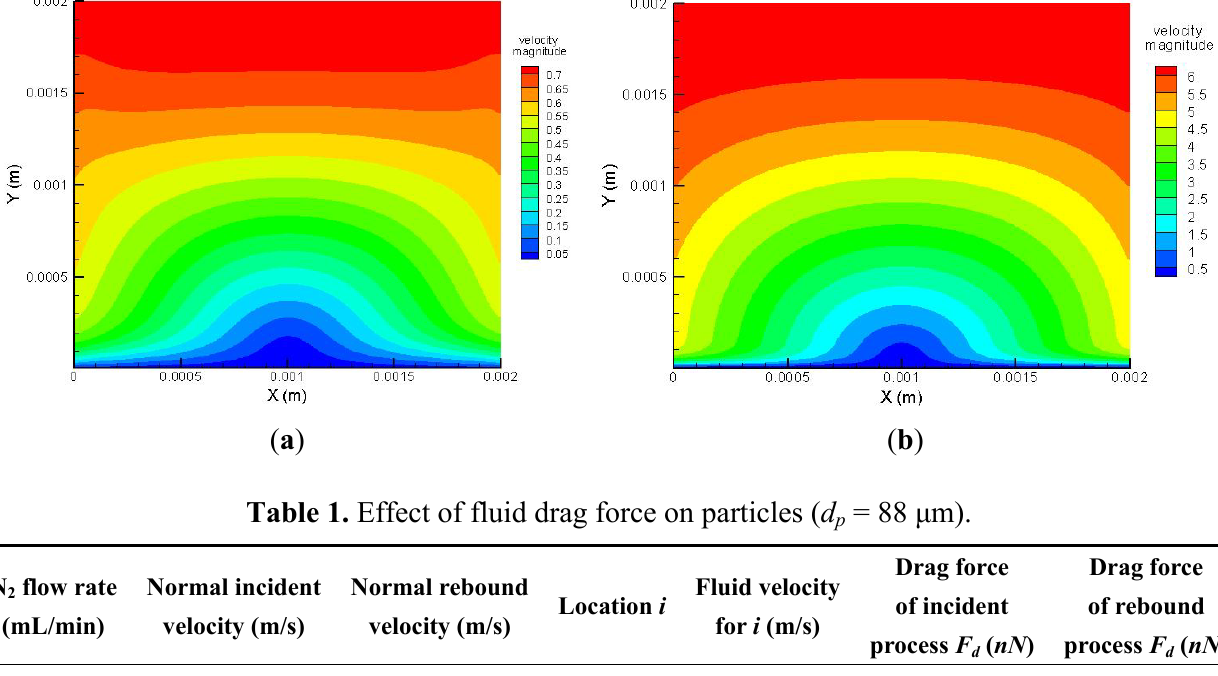
Figure 3. The velocity field under different outlet velocity magnitudes of the particle export pipe. ( a ) The outlet velocity magnitude of particle export; and ( b ) the outlet velocity magnitude of particle export pipe is 0.74 m/s. Pipe is 6.37 m/s.